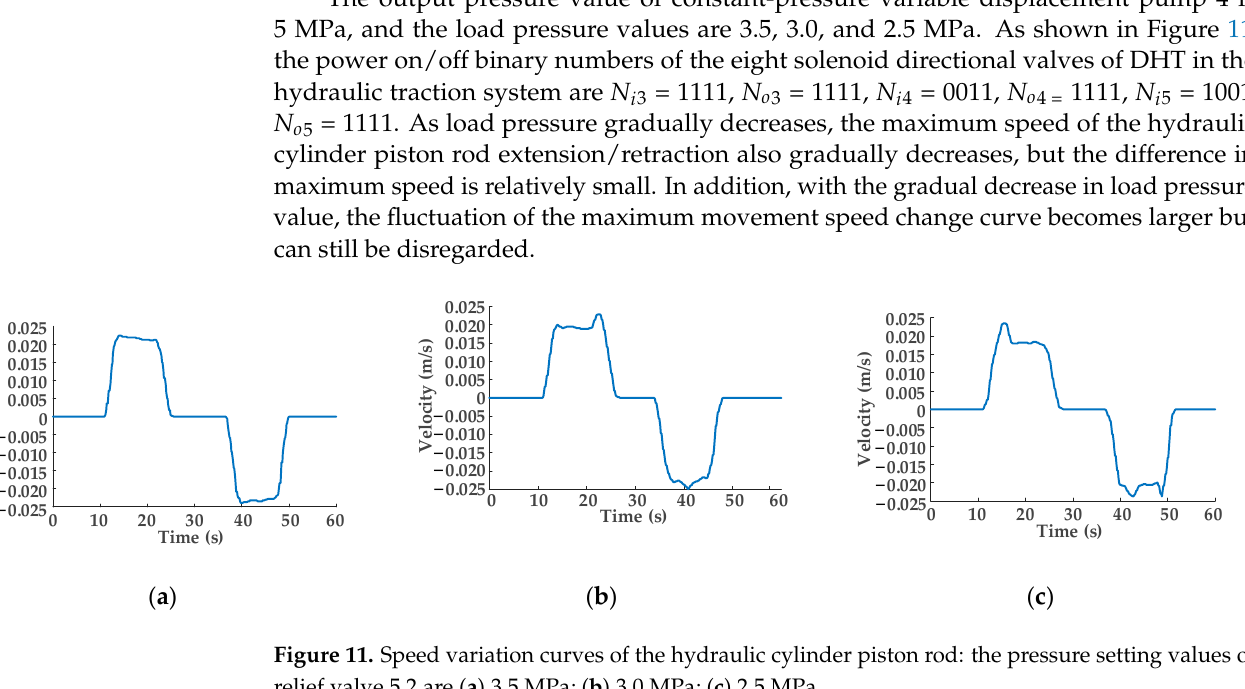
Figure 11. Speed variation curves of the hydraulic cylinder piston rod: the pressure setting values of relief valve 5.2 are ( a ) 3.5 MPa; ( b ) 3.0 MPa; ( c ) 2.5 MPa.